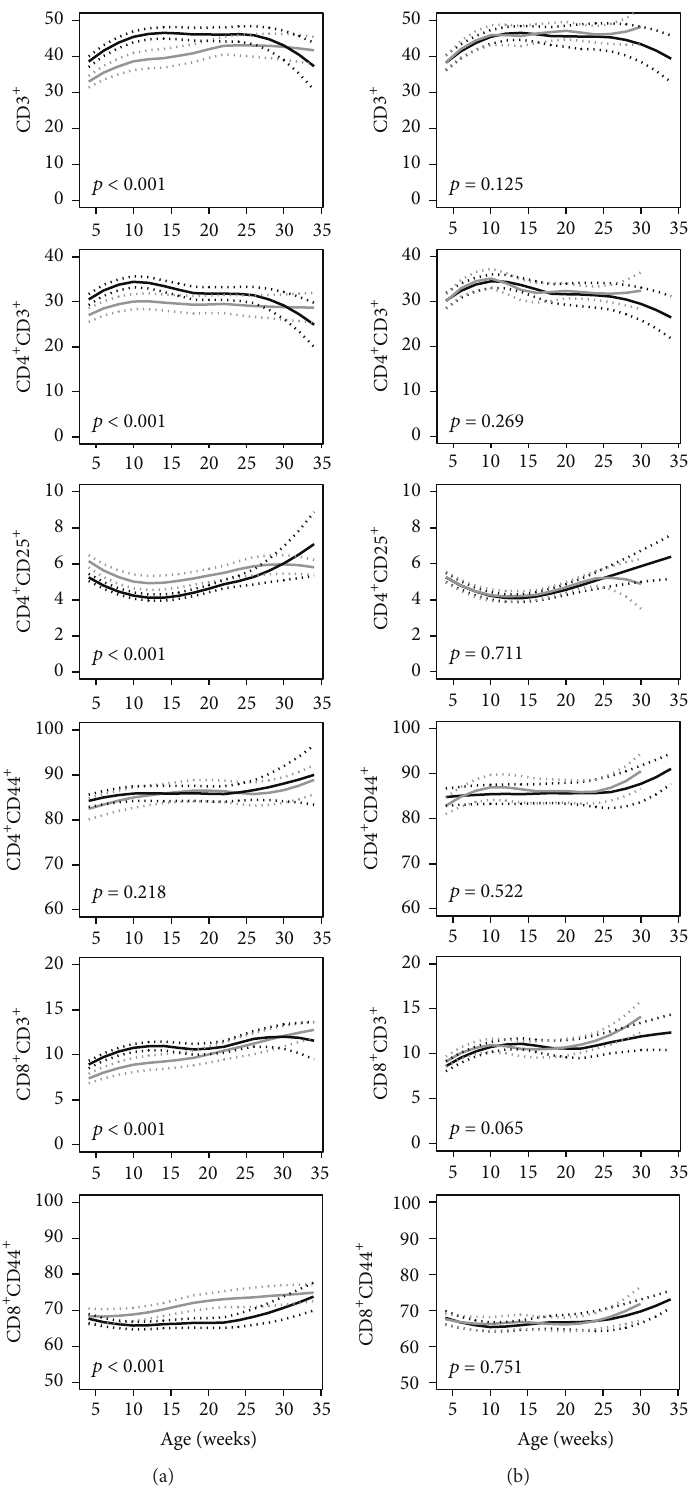
Figure 3: Trajectories of peripheral blood percentages of T lymphocyte populations in (a) NOD mice (black line) versus NOR mice (gray line) and (b) NOD mice that developed diabetes (black line) versus NOD mice that were diabetes-free at age of 36 weeks (gray line). The unbroken lines represent 95% confidence intervals of the trajectories. 𝑝 values for the comparisons are shown in each